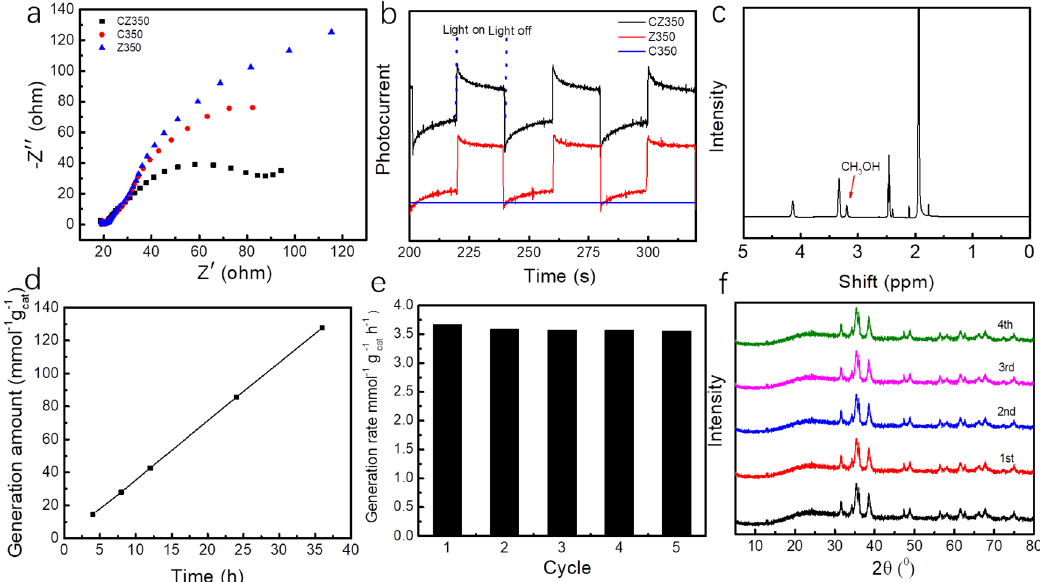
Figure 3. Electrochemical impedance spectroscopy (EIS) spectra ( a ), photocurrent density of different catalysts ( b ), nuclear magnetic resonance (1H NMR) spectra of liquid product for solution catalyzed by CZ350 ( c ), the production of methanol varies with time ( d ) and the generation rate of methanol ( e ), XRD patterns of CZ350 for different cycles ( f ).